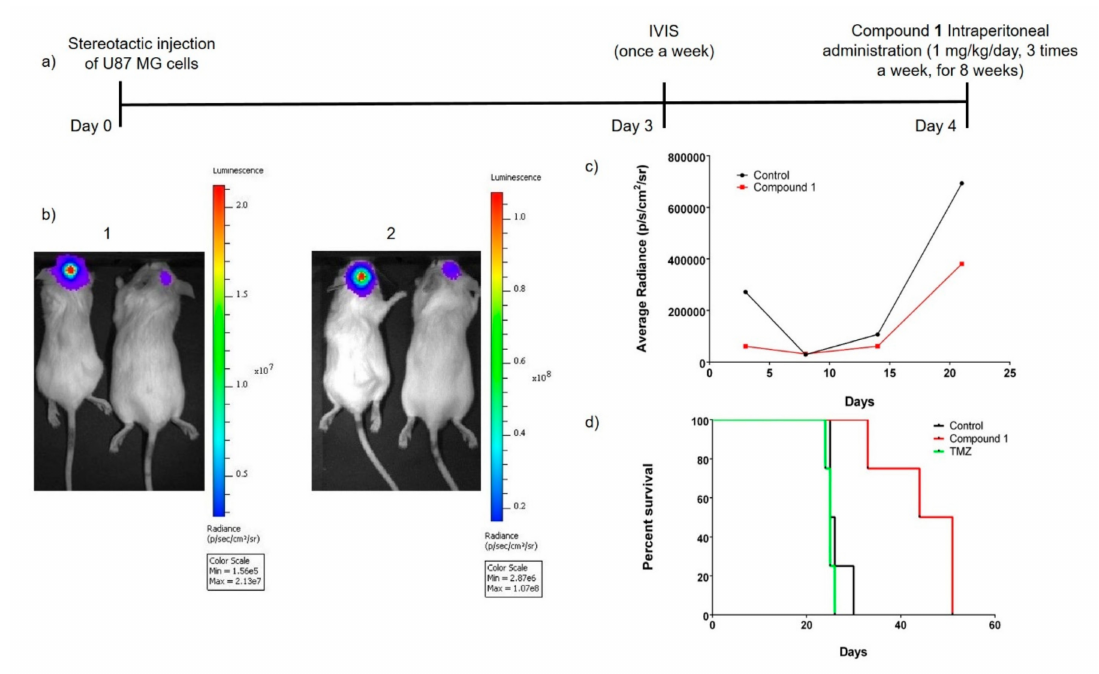
Figure 7. ( a ) Dosification schedule. ( b ) Selected images of the evolution of glioblastoma correspond to 14 days ( 1 ) and to 21 days ( 2 ) after cell injection; in each case the left mouse was an untreated control and the right one was treated with compound 1 . ( c ) Weekly evolution of glioblastoma sizes; in black untreated control and in red treated with 1 . In the third week (day 21st) the study was ended because all the untreated animals died. ( d ) Kaplan–Meier survival curves of mice bearing glioblastoma receiving di ff erent treatments. Black: untreated animals; green: Tmz (4 mg / kg / day)-treated animals; red: compound 1 (1 mg / kg / day)-treated animals. The study showed a significant di ff erence either between compound 1 and control (untreated animals) or 1 and Tmz ( p < 0.01). Data were analyzed by log-rank